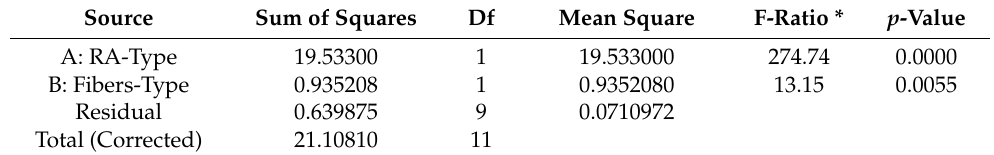
Table 11. Analysis of the Variance for the values of Compression Resistance (MPa). Source Sum of Squares Df Mean Square F-Ratio * p -Value A: RA-Type 19.53300 1 19.533000 274.74 0.0000 B: Fibers-Type 0.935208 1 0.9352080 13.15 0.0055 Residual 0.639875 9 0.0710972